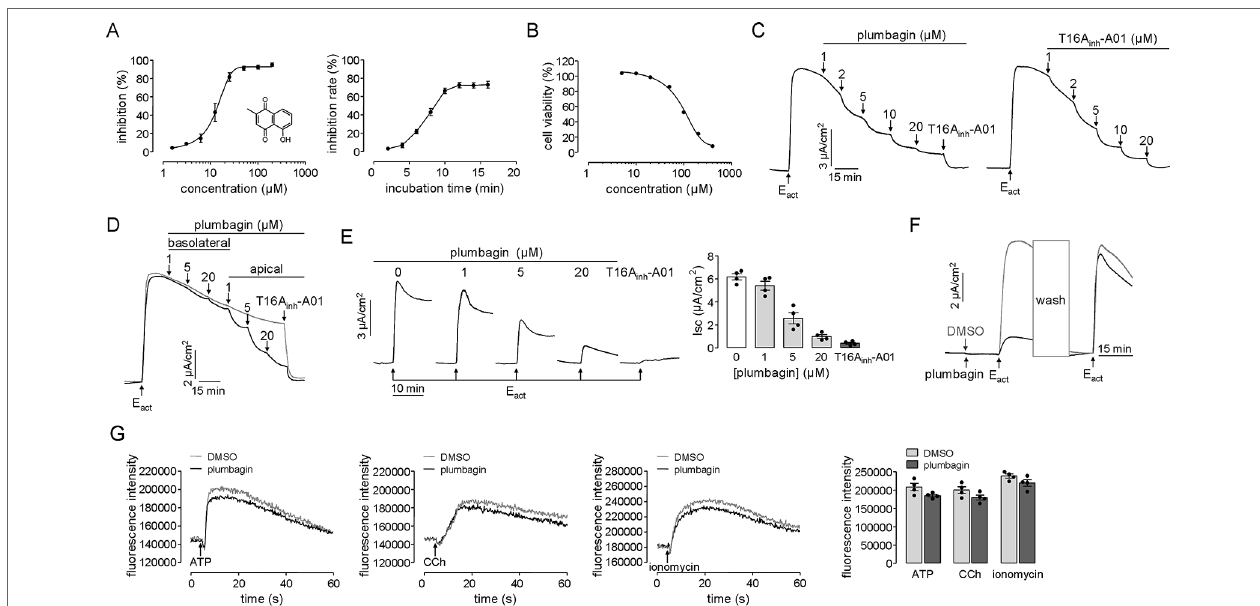
FIGURE 1 | Inhibition of TMEM16A chloride channel activity by plumbagin. (A) Fluorescence assays in FRT-TMEM16A-YFP-H148Q/I152L cells. Left panel: Dose- dependent inhibition of TMEM16A activity by plumbagin and the structure of plumbagin. Right panel: Time-course inhibition of TMEM16A by plumbagin (n = 4). (B) MTT assay in TMEM16A -expressed FRT cells (n = 6). (C) Plumbagin inhibition of the short-circuit current induced by E act (10 μM) in FRT cells expressing TMEM16A .